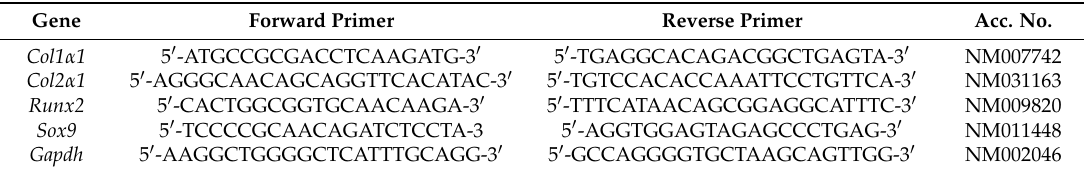
Table 1. Primers designed to amplify selected genes for real time RT-PCR